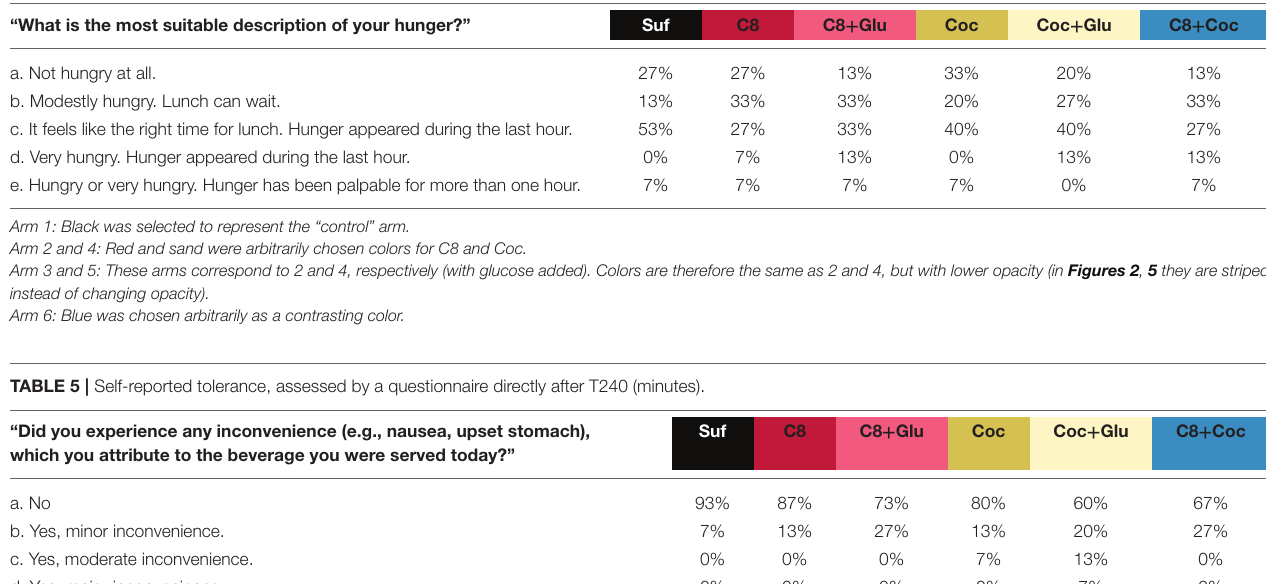
TABLE 4 | Self-reported satiety, assessed by a questionnaire directly after T240 (minutes). “What is the most suitable description of your hunger?” Suf C8 C8 + Glu Coc Coc + Glu C8 + Coc